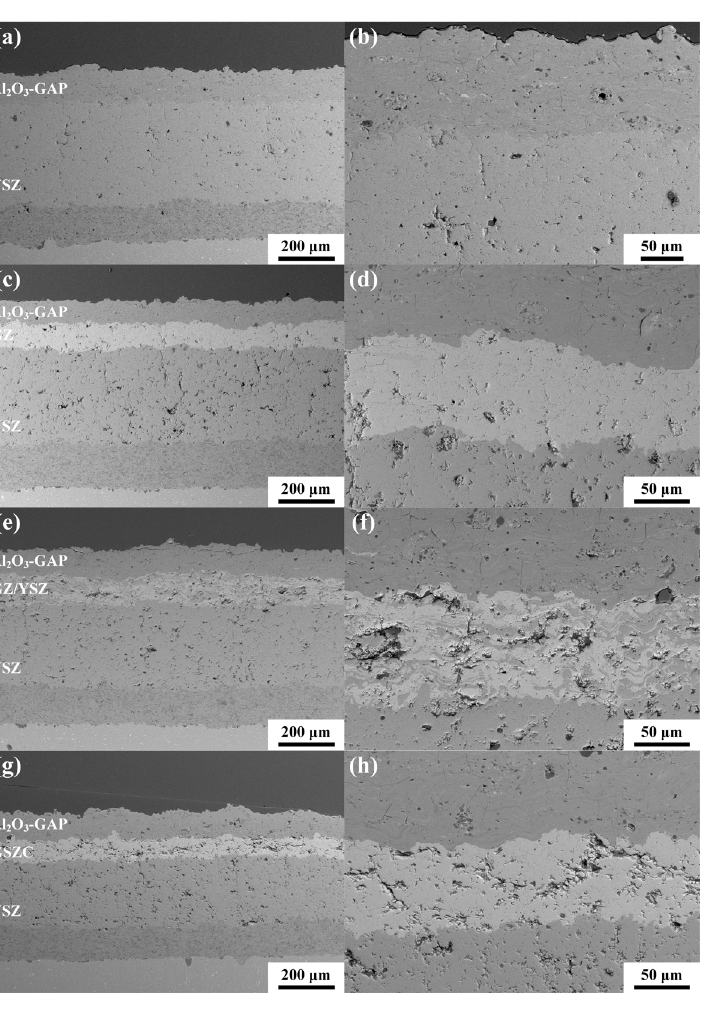
Figure 3. Cross-sectional morphologies of the as-sprayed ( a , b ) AGAP-YSZ, ( c , d ) AGAP-GZ-YSZ,